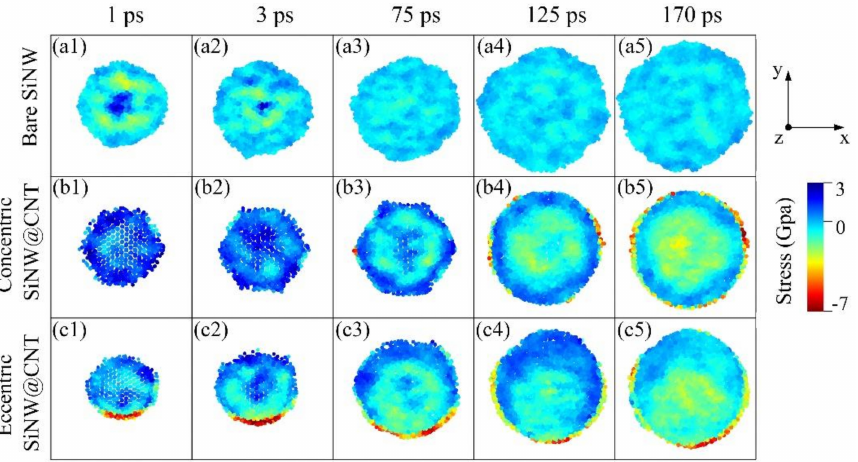
Figure 7. Stress-distribution maps of ( a1 – a5 ) bare SiNW, ( b1 – b5 ) concentric SiNW@CNT, and ( c1 – c5 ) eccentric SiNW@CNT during lithiation, positive (+) and negative ( − ) values correspond to tensile and compressive stresses,